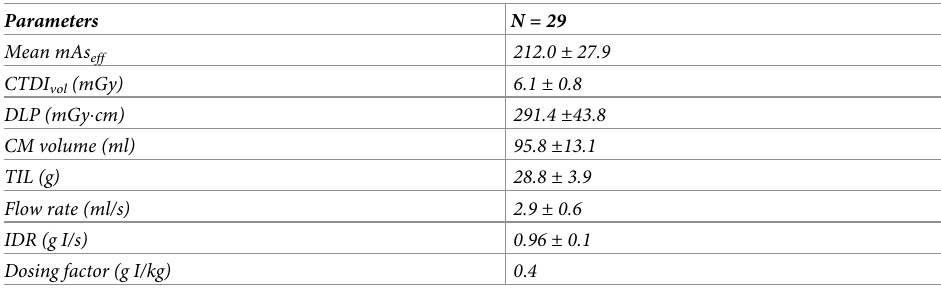
Table 2. Radiation dose and injection